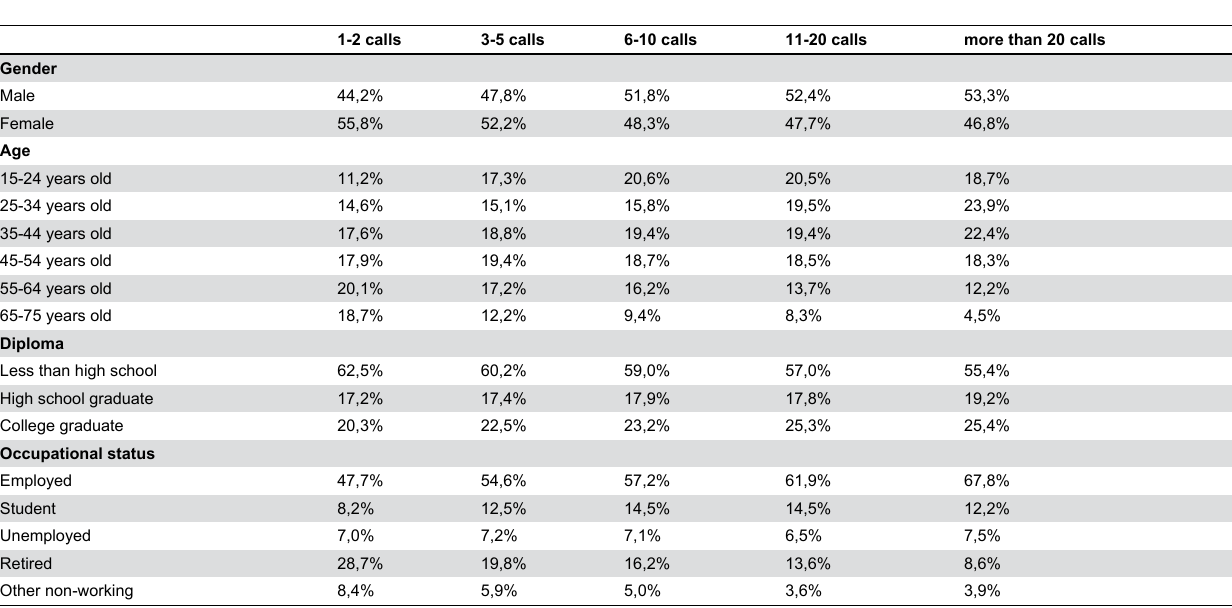
Table 2. Socioeconomic characteristics of the 15-75 years-old interviewed in the Health Barometer according to the number of calls before the interview.